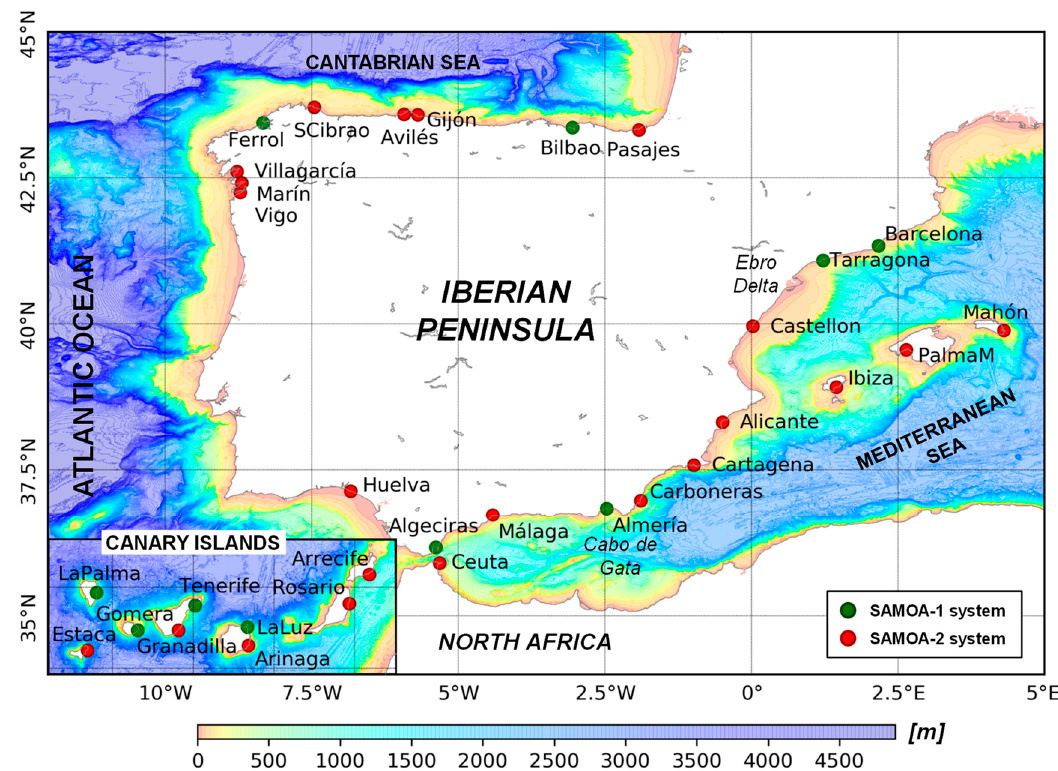
Figure 2. SAMOA Coastal/Port circulation forecast systems in operations. Green dots: Operational models systems developed within SAMOA1 (2014–2017). Red dots: Operational model systems developed within SAMOA2 (2018–2021). Bathymetry (in meters) is depicted. Note that systems in the Canary Islands are shown in the bottom left corner box (SW limit: 18.5° W, 27.5° N; NE limit: 13.2° W, 29.5° N).